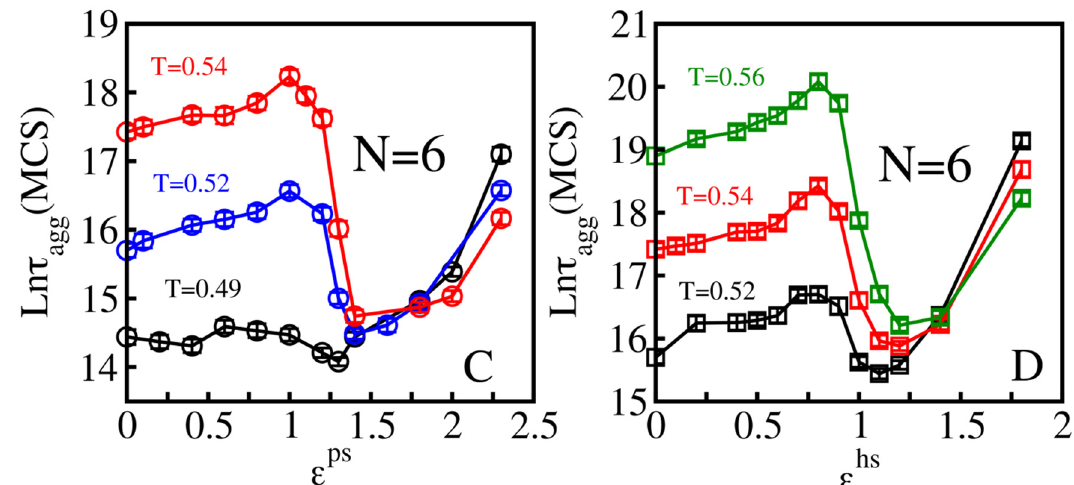
Figure 4. Dependence of ln τ agg on the interaction of the systems consisting of N = 6 polypeptide chains for hydrophilic ( A , C ) and hydrophobic ( B , D ) smooth surfaces. The upper row exhibits the simulation at T = 0.54, the values ε ps1 = 1.0, ε ps2 = 1.4, ε hs1 = 0.8 and ε hs2 = 1.2 (black dashed lines) separate the three interaction regions corresponding to the three types of surfaces. Between ε ps1 = 0.9 and ε ps2 = 1.25 (blue dashed lines), we observed the U-shape dependence of ln τ agg on the roughness degrees Θ for an S-point hydrophilic surface. A similar behavior occurs for a hydrophobic surface between ε hs1 = 0.7 and ε hs2 = 0.95 (blue dashed lines). The notations “ps” and “hs” refers to a hydrophilic and hydrophobic surface, respectively. The bottom row also shows correlation of ln τ agg and interaction parameters ε ps of hydrophilic ( C ) and ε hs hydrophobic ( D ) smooth surfaces for various temperatures and wider ranges of the interaction val- ues. The bottom row shows the dependence of ln τ agg on the interaction parameter ε ps of hydrophilic ( C ) and ε hs of hydro- phobic ( D ) smooth surfaces for various temperatures. Error bars are lower than data symbols.